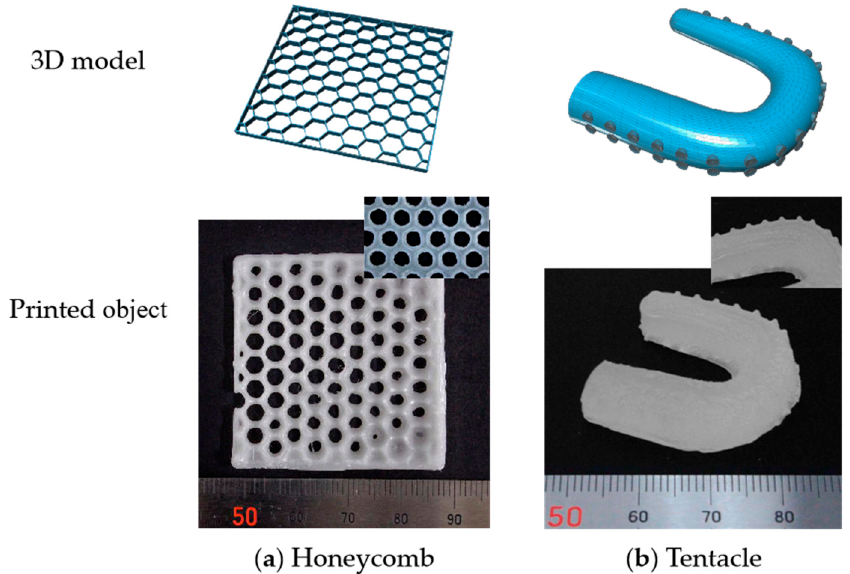
Figure 6. 3D model data designed using the 123D Design software, and 3D objects fabricated on LumiForge with more complex shapes of honeycomb ( a ) and tentacle ( b ). The printed objects had high printing precision both on milli- and micro- meter scales.